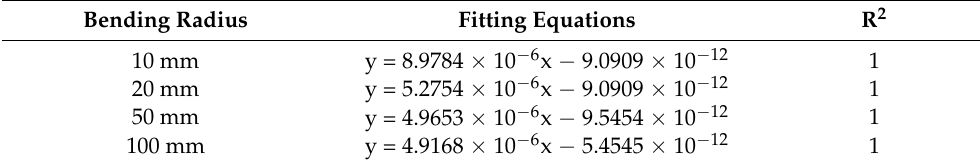
Table 1. Fitting equation of the acoustic pressure with respect to the heat source strength. Bending